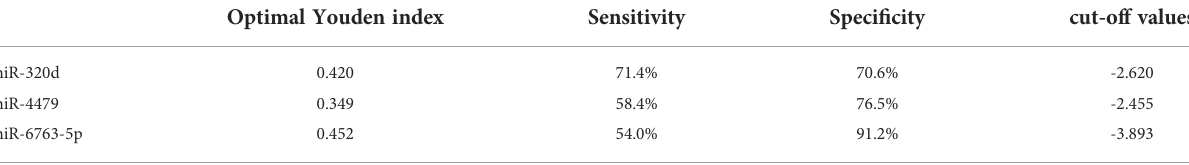
TABLE 5 Cut-off values of exosomal miR-320d, miR-4479, and miR-6763-5p between benign diseases patients and EOC